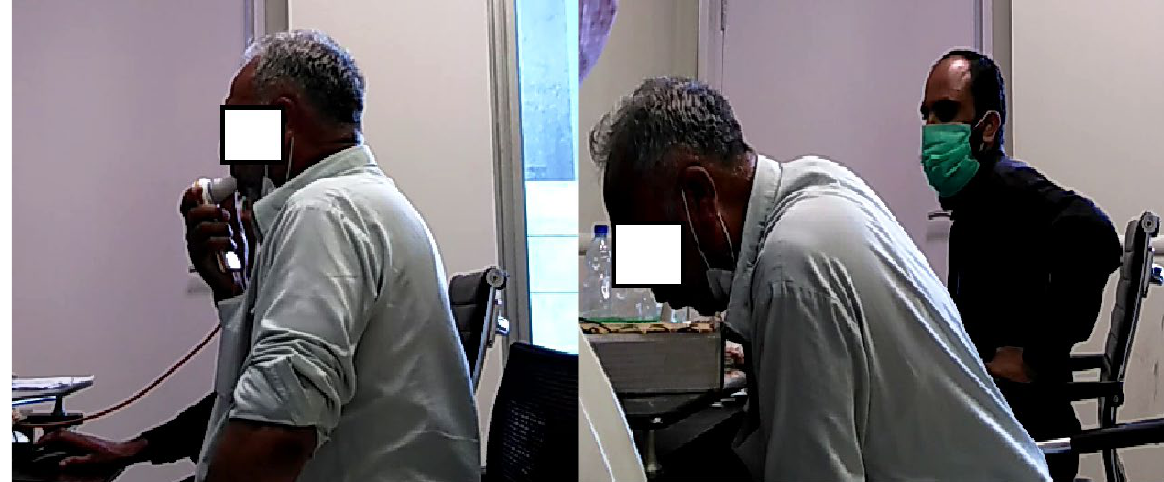
Figure 1. Recording of Pulmonary Function Test (PFT) on the left and recording of Exhaled Breath Compounds on the right.